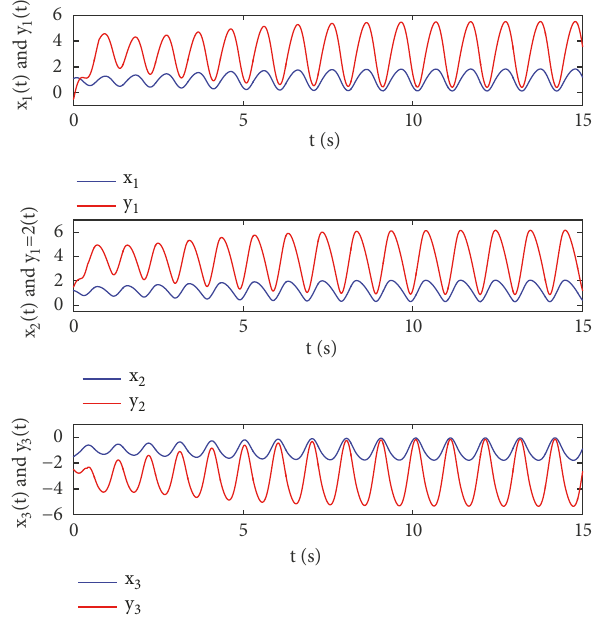
Figure 10: State trajectories of master-slave systems with 𝜉 = 3.